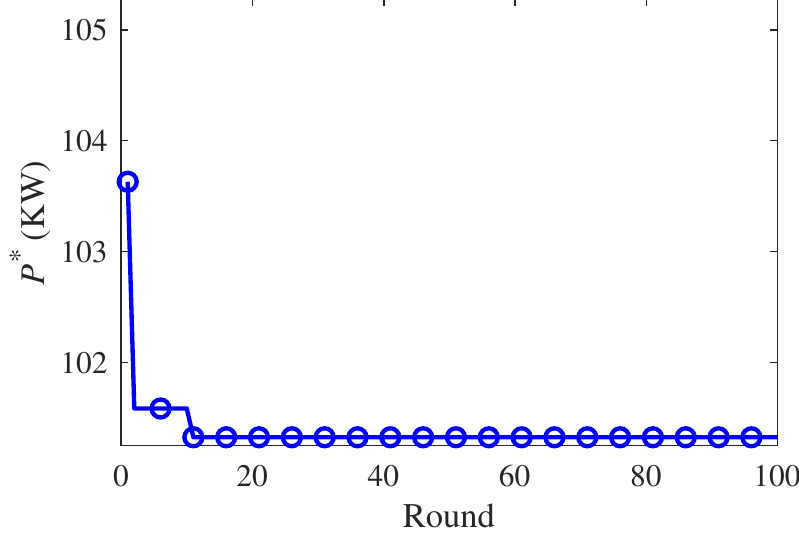
Figure 9. The iteration of BRS on hardware